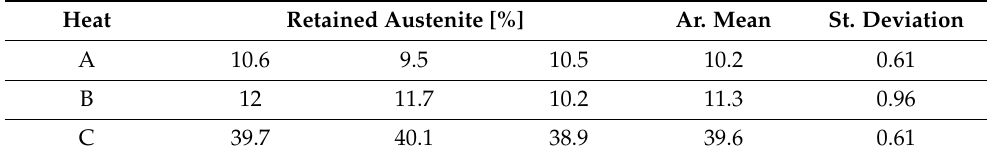
Figure 16. Determination of the proportion of retained austenite in the structure cooled from 1100 °C—heat C (7 wt% Al). Table 3. Amount of untransformed austenite in the structure of each heat after quenching from 1100 °C.